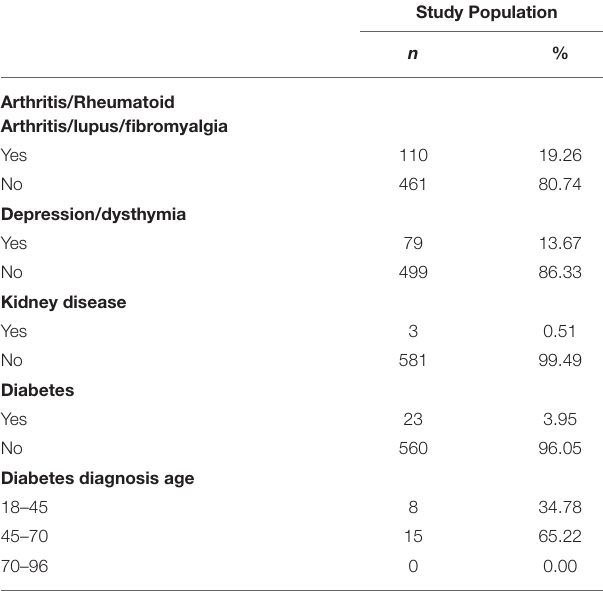
TABLE 1 | Population characteristics for participants who provided questionnaire